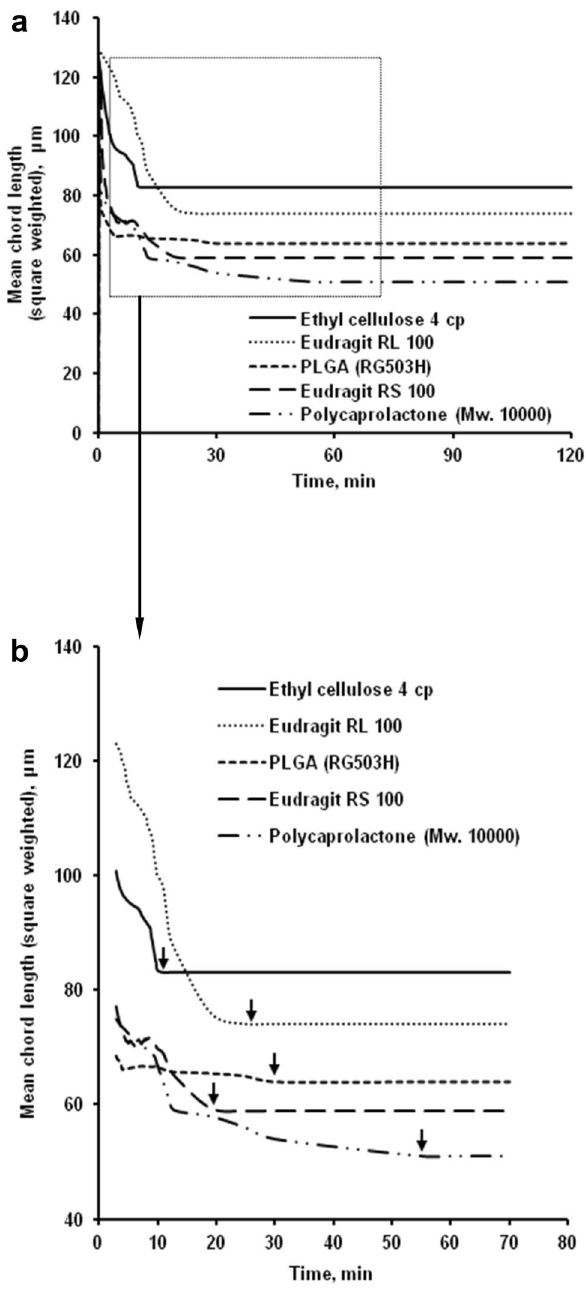
Figure 1. Effect of polymer type on square weighted mean chord length during microparticle formation by O/W method ( a ) whole process and ( b ) hardening time of microparticle; arrow ( ↓ ): starting time of microparticle